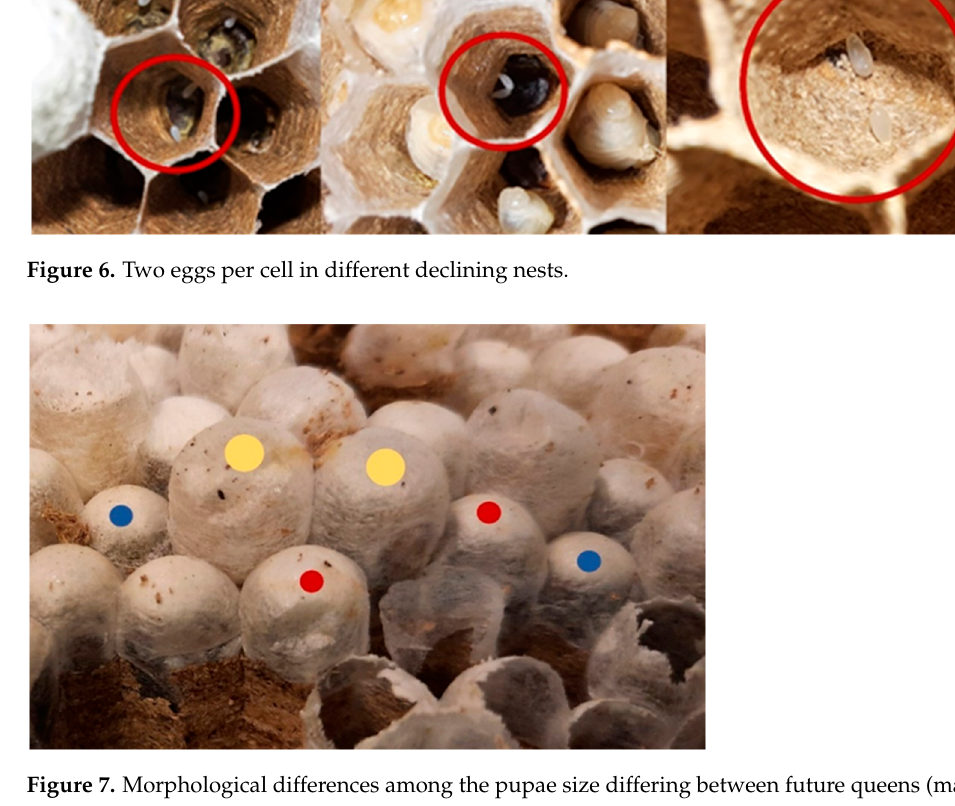
Figure 7. Morphological differences among the pupae size differing between future queens (marked with yellow points), workers (red points), and males (blue points).